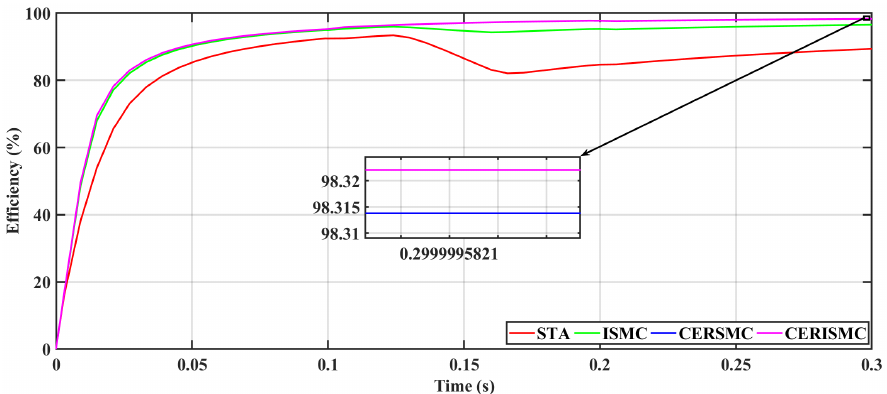
Figure 11. Efficiencies under varying irradiance, temperature, load and a charging